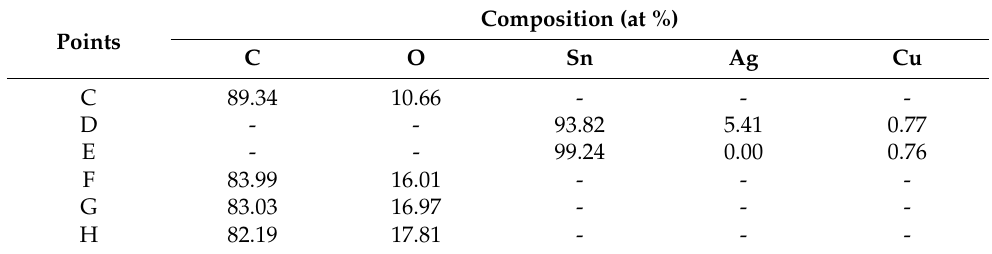
Table 1. EDS results of different points in Figure